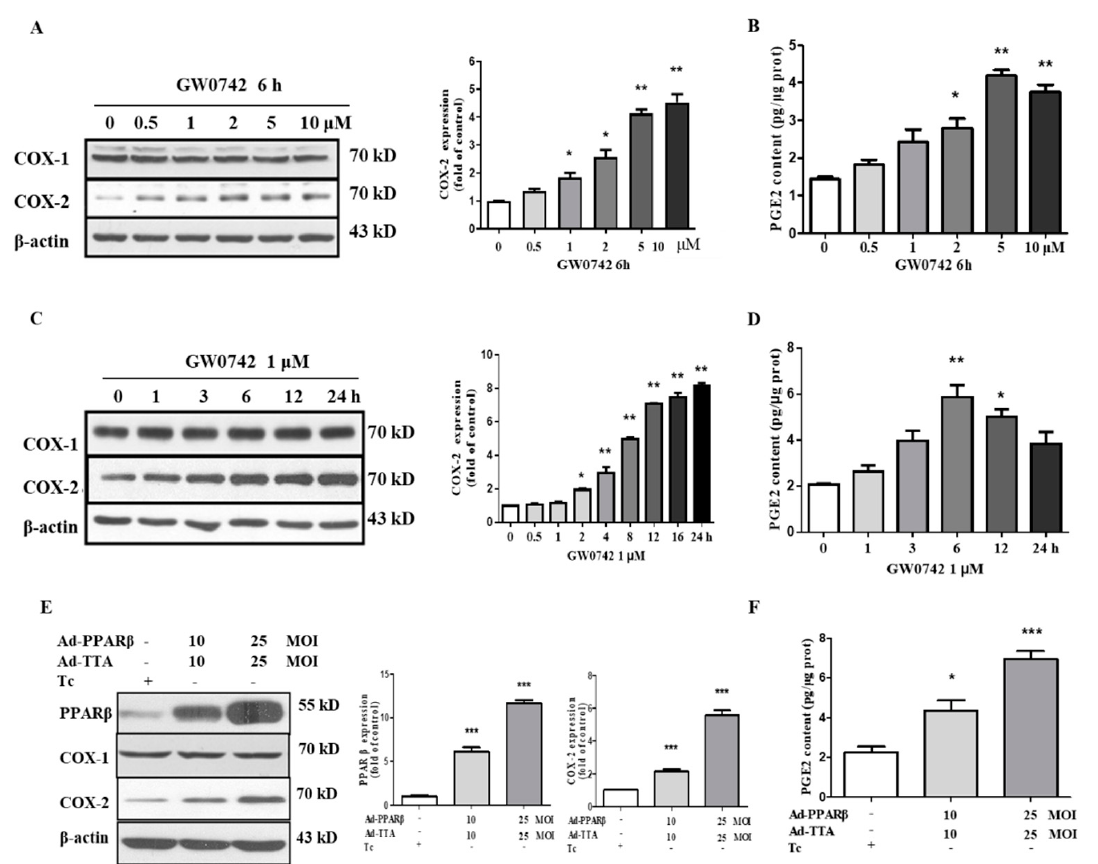
Figure 2. PPAR β / δ increases COX - 2 expression and PGE2 production in human glomerular mesangial cells. ( A ) PPAR β / δ activation dose-dependently induced COX-2 expression. The cells were treated with various concentrations of GW0742 (0.5, 1, 2, 5, and 10 μ M) for 6 h. COX-1 and COX - 2 protein expressions were examined using Western blot. * p < 0.05 and ** p < 0.01 compared to the control (0 ng/mL). ( B ) GW0742 dose-dependently induced PGE2 production. * p < 0.05 and ** p < 0.01 compared to the untreated control; n = 4. ( C ) A Western blot assay demonstrated that GW0742 (1 μ M) time-dependently induced COX - 2 expression. * p < 0.05 and ** p < 0.01 compared to the control (0 h). ( D ) GW0742 treatment increased PGE2 production in a time-dependent manner. * p < 0.05 and ** p < 0.01 vs. the untreated control; n = 4. ( E ) PPAR β / δ overexpression increased COX - 2 expression as assessed by Western blot. The cells were infected with Ad-PPAR β / δ and Ad-TTA with or without 0.1 μ g/mL tetracycline for 24 h. *** p < 0.001 compared to the control. ( F ) The adenovirus-mediated overexpression of PPAR β / δ induced PGE2 production. * p < 0.05, and *** p <